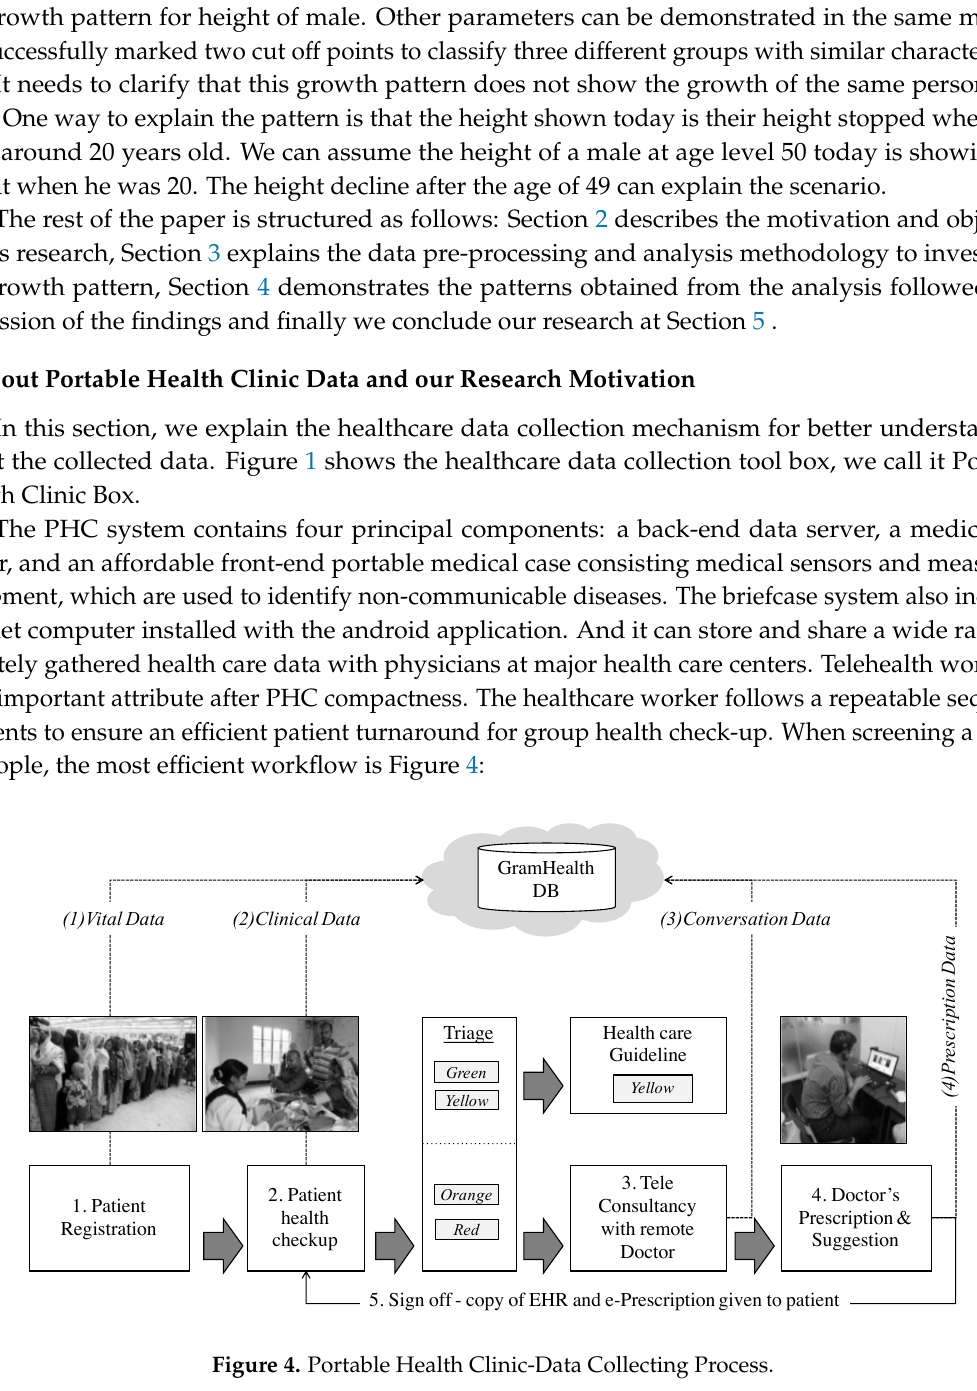
Figure 4. Portable Health Clinic-Data Collecting